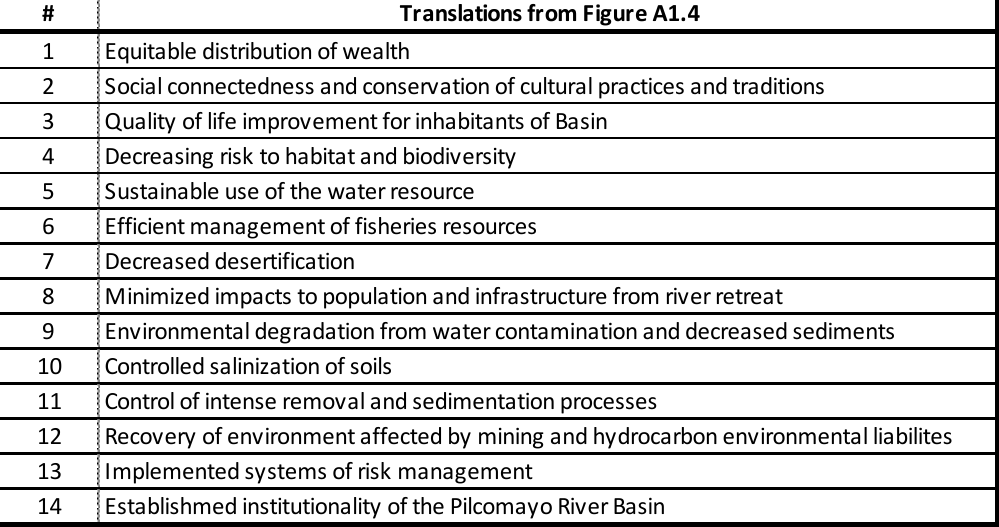
Translations from Figure